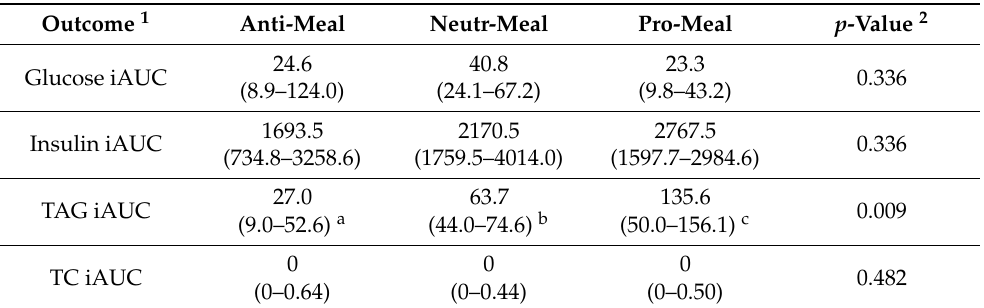
Table 5. Postprandial plasma glucose, insulin, and serum lipid measures for Anti-meal, Neutr-meal and